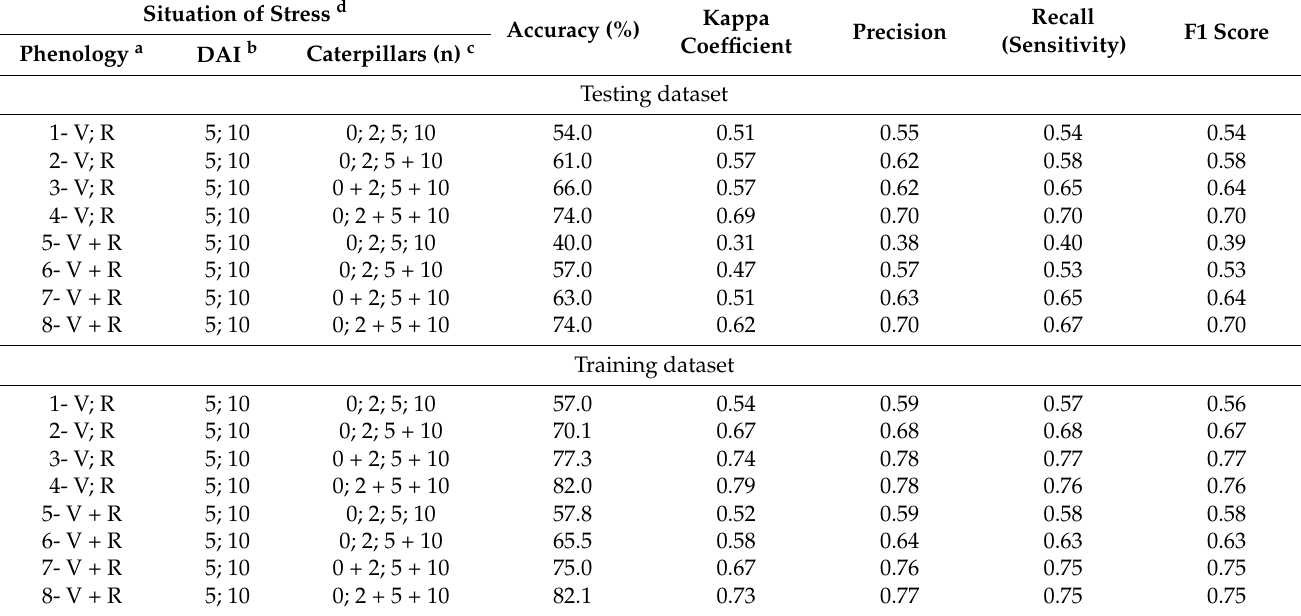
Table 5. Results for accuracy, Kappa coefficient, precision, recall, and F1 score for the testing and training datasets for discrimination of soybean plants under different situations of stress caused by S. eridania based on multilayer perceptron artificial neural